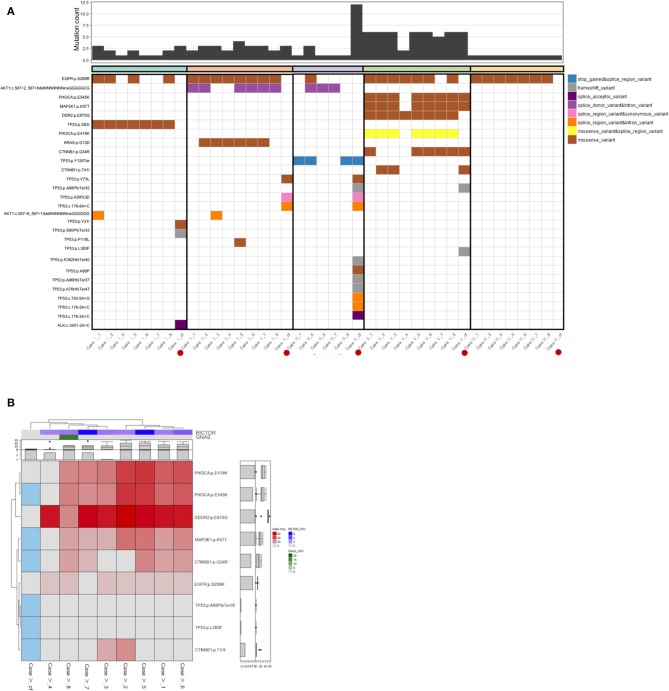
(A) Genomic landscape of mutations detectable by both the Archer solid tumor and cfDNA assay. We focused on the 20 genes common to both assays to analyze mutational heterogeneity from endoscopic multi-sector tissue sampling and cfDNA. Case III represented a case with the greatest number of non-shared mutations detected in cfDNA but not tumor tissue, while Case VI was representative of a case with no detectable cfDNA alterations. (B) Heat map of detected gene mutations in Case V. The mutational allele fraction of genes with detectable alterations from the Archer solid tumor panel were standardized and represented as a heat map. For cfDNA, detection was dichotomously represented, with Blue indicating detection, and Gray indicating no detection. Case V among the six cases was representative of the greatest number of shared alterations between the solid tumor panel and cfDNA testing.